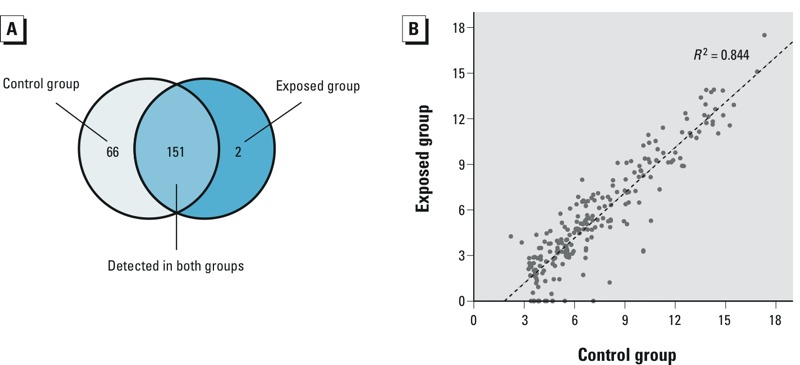
miRNA expression profiles in the discovery stage. (A) Distribution of miRNAs in the control group and the exposed group. (B) Scatter plots showing the relationship of the log2-transformed expression levels of miRNAs between the two groups.